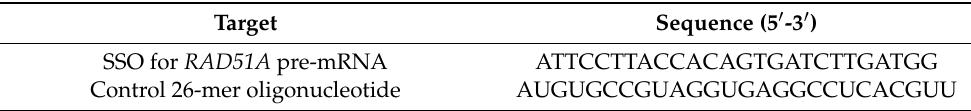
Table 1. Oligonucleotides used for CD4 + T cell